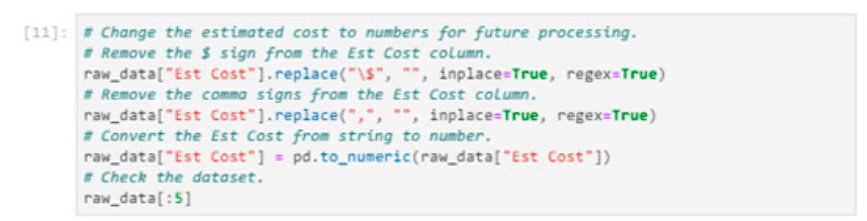
Figure 11. Sample code fixing data type.